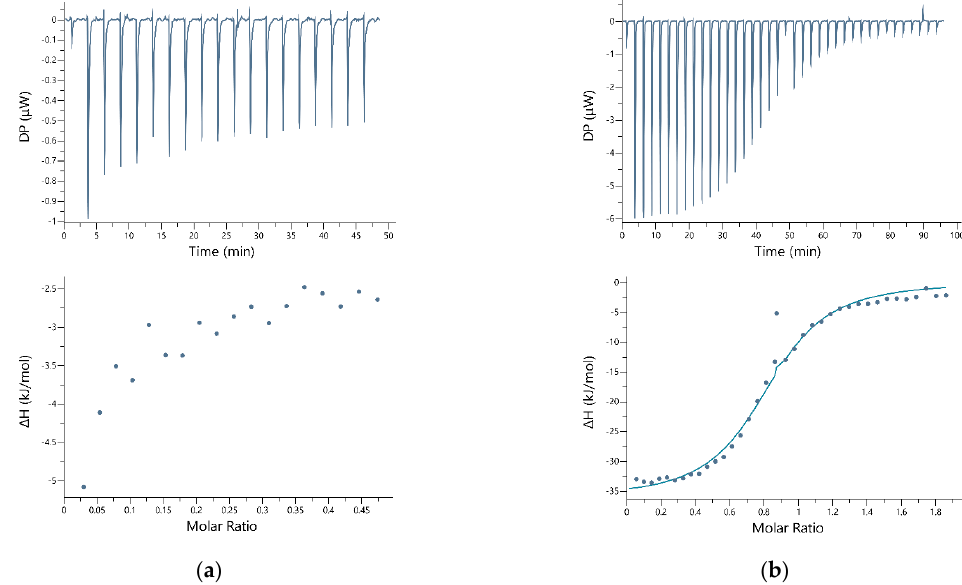
Figure 4. Isothermal titration calorimetry results of the cyclic nickel-binding peptide CNAKHHPRCGGG with Co 2+ ions in TBS + NaCl, pH 7.4 ( a ) and the cyclic cobalt-binding peptide CTQMLGQLCGGG with Ni 2+ ions in TBS + NaCl, pH 7.4 ( b ). Top: raw heat rate ( µ W) vs. time (min). Bottom: changes in enthalpy (kJ/mol) vs. molar ratio of the reactants. The data were fitted using a one-set-of-sites